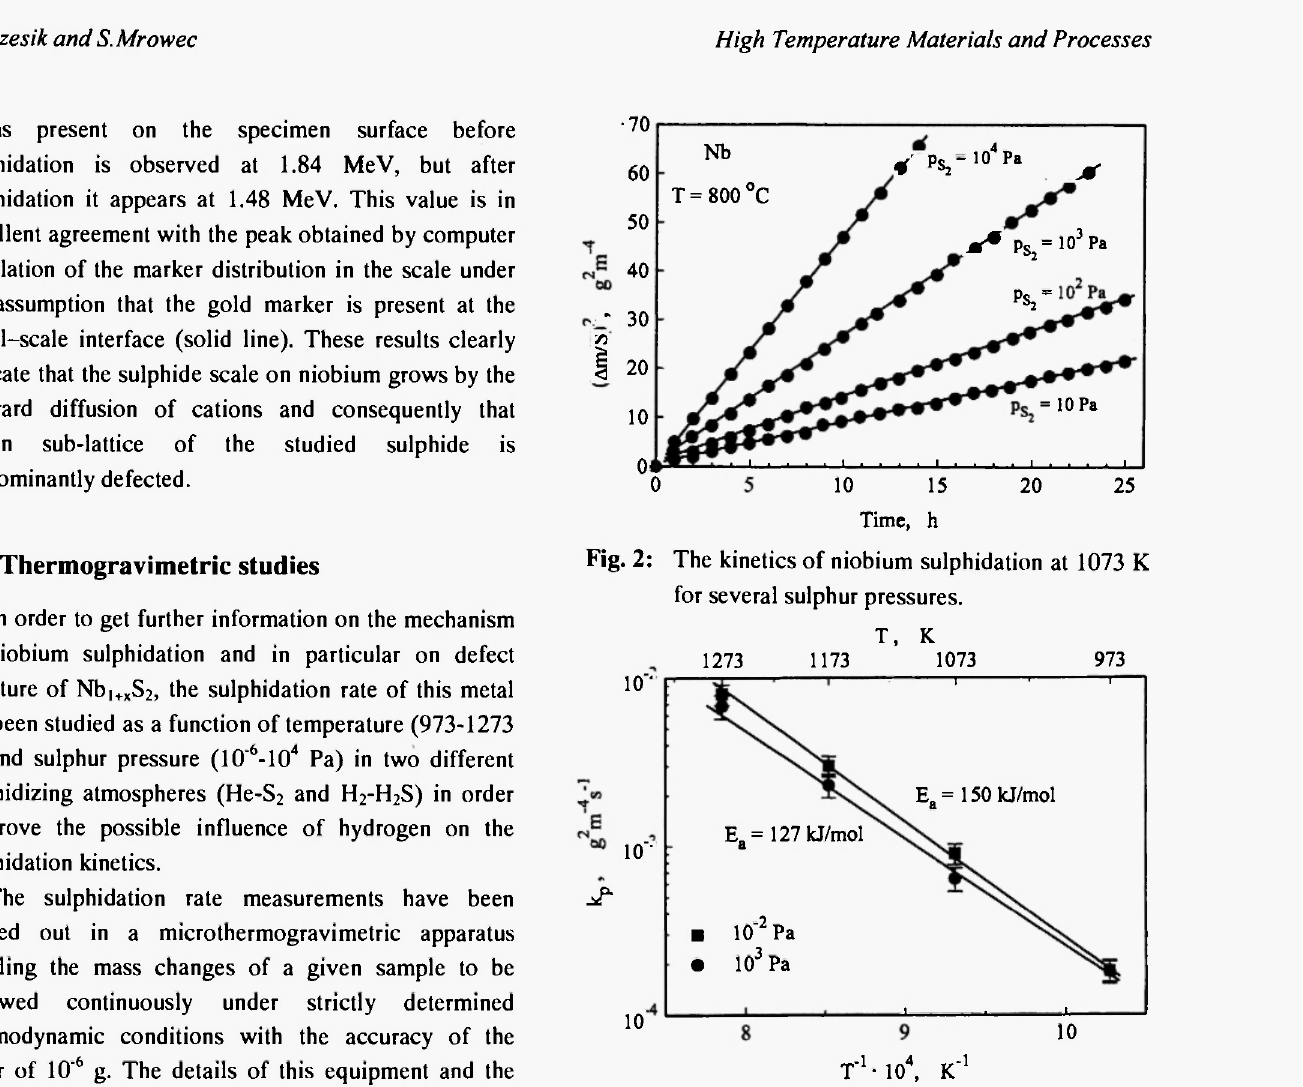
Fig. 3: Temperature dependence of the parabolic rate constant of niobium sulphidation, in Arrhenius plot.